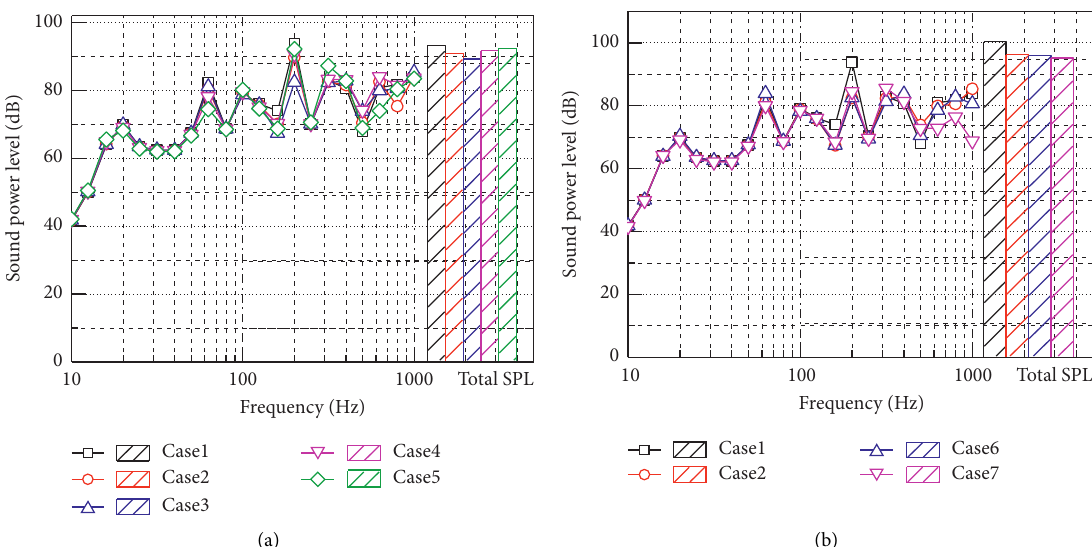
Figure 15: Variation of the sound power level with the characteristics of rib distribution. (a) Variation of the sound power level for various numbers of the ribs. (b) Variation of the sound power level for various arrangements of the